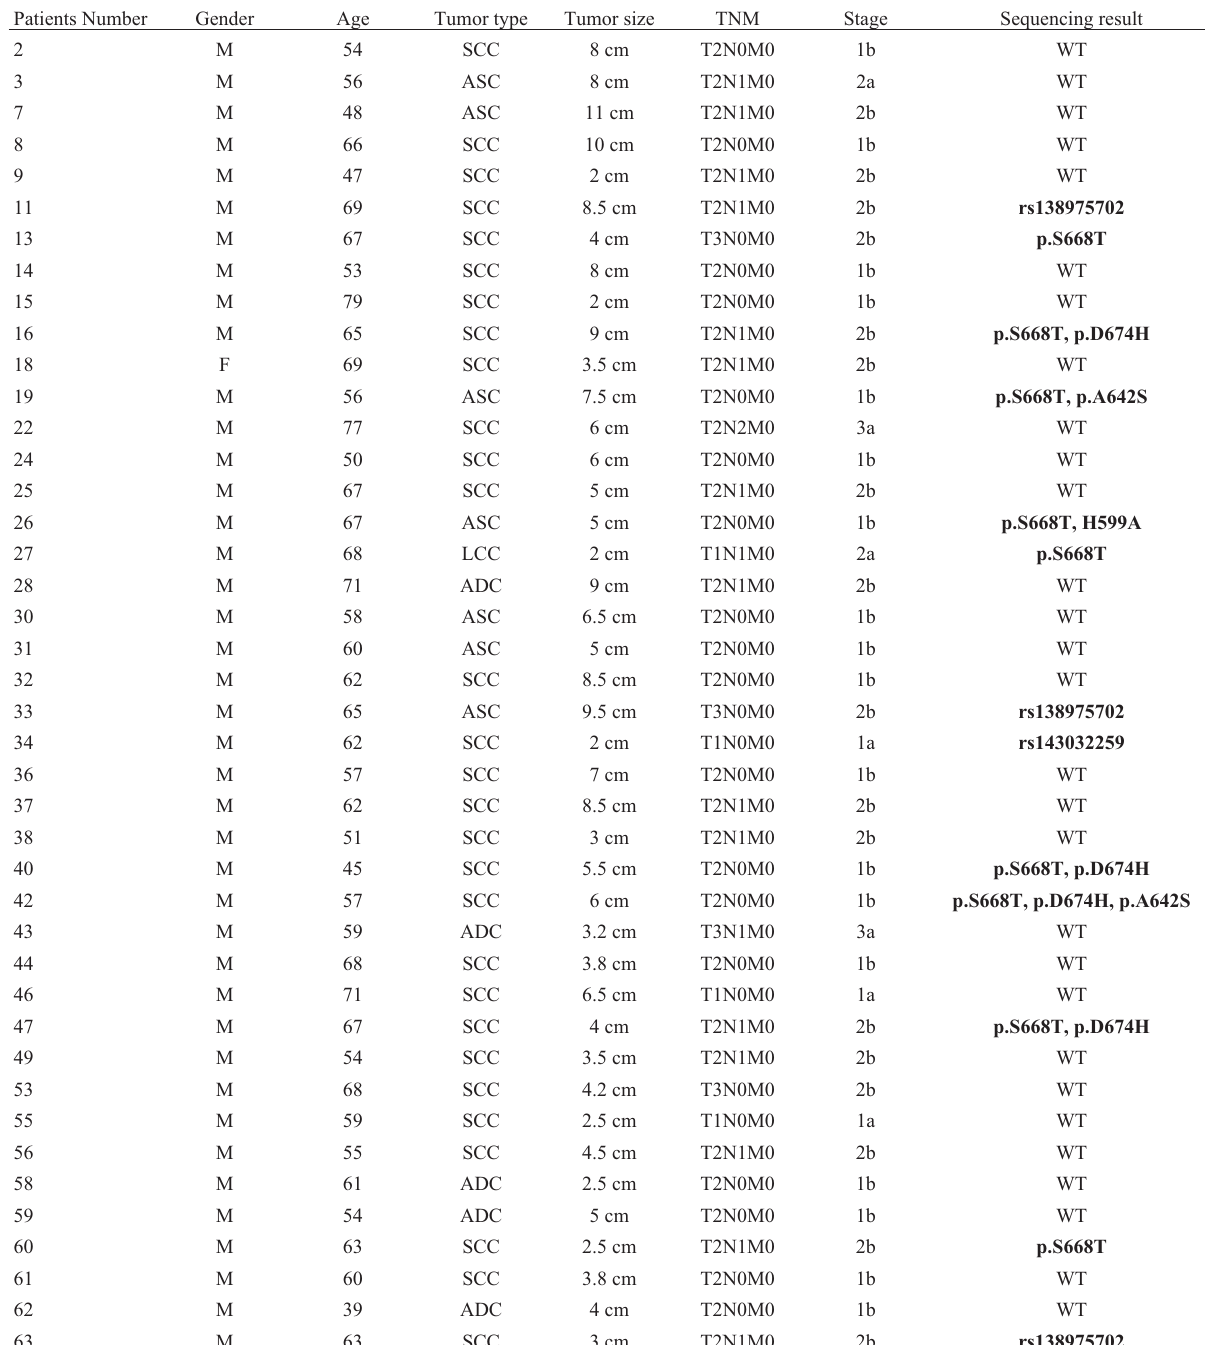
Table 1 - Clinical features of NSCLC patients with sequence results of IRS1 gene (SCC: Squamous cell carcinoma, ADC: Adenocarcinoma, LCC:Large cell carcinoma, ADC: Adenosquamous carcinoma ; M: Male, F:Female, WT: Wild Type) Patients